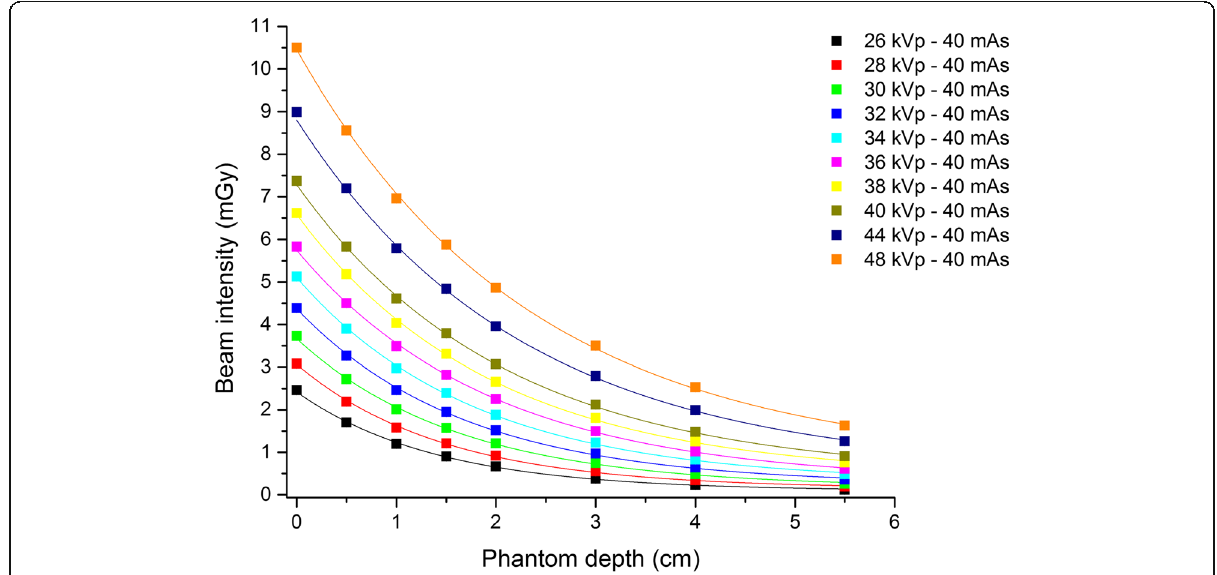
Fig. 1 Beam intensity as a function of the phantom depth for different tube voltage values (26 – 48 kVp). An exponential relationship (Eq. (4)) was employed to fit the data and obtain the m values for different tube